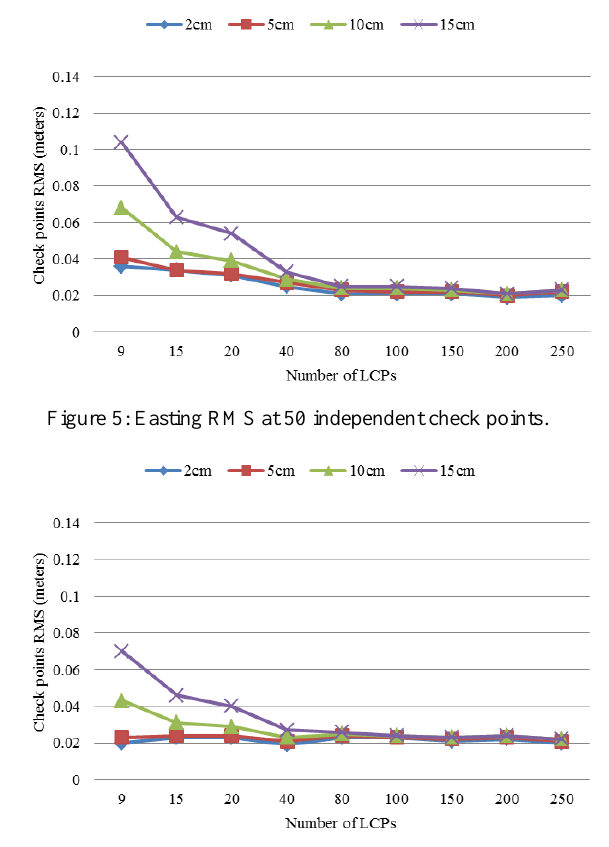
Figure 4: Interpolated lidar surface.